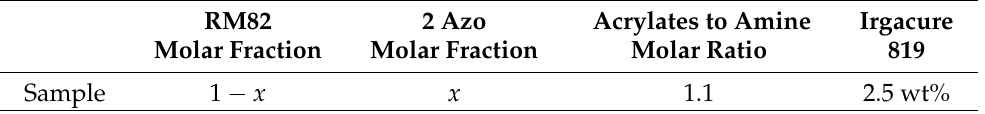
Figure 1. Schematic and constituents of one studied system. Table 1. The relative quantities of the